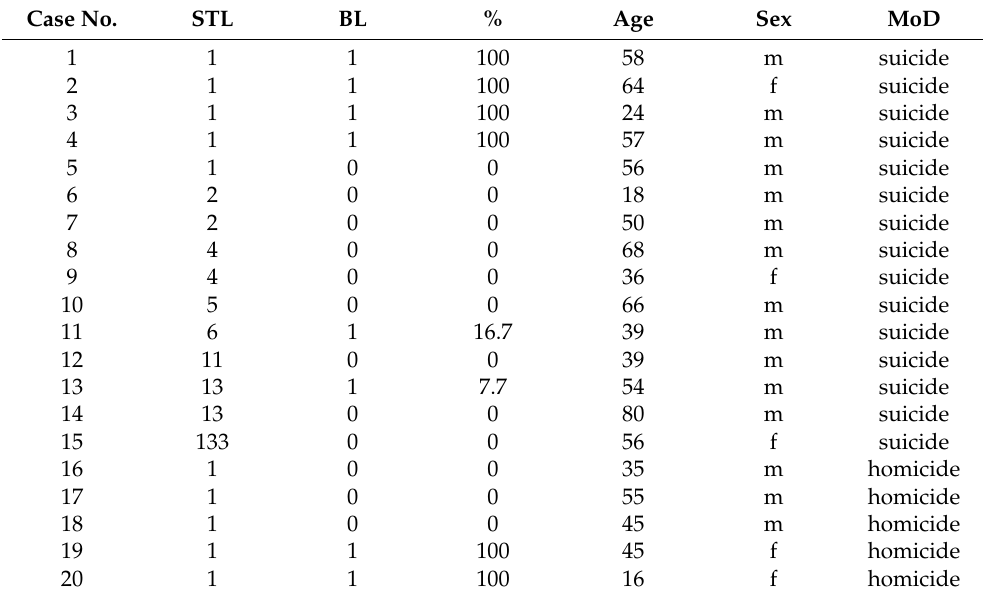
Table 1. List of 41 cases, number of soft tissue (STL) and bone lesions (BL), with frequency (%) of lesions penetrating to the bone, age-at-death (age), sex and the manner of death (MoD). Case No.